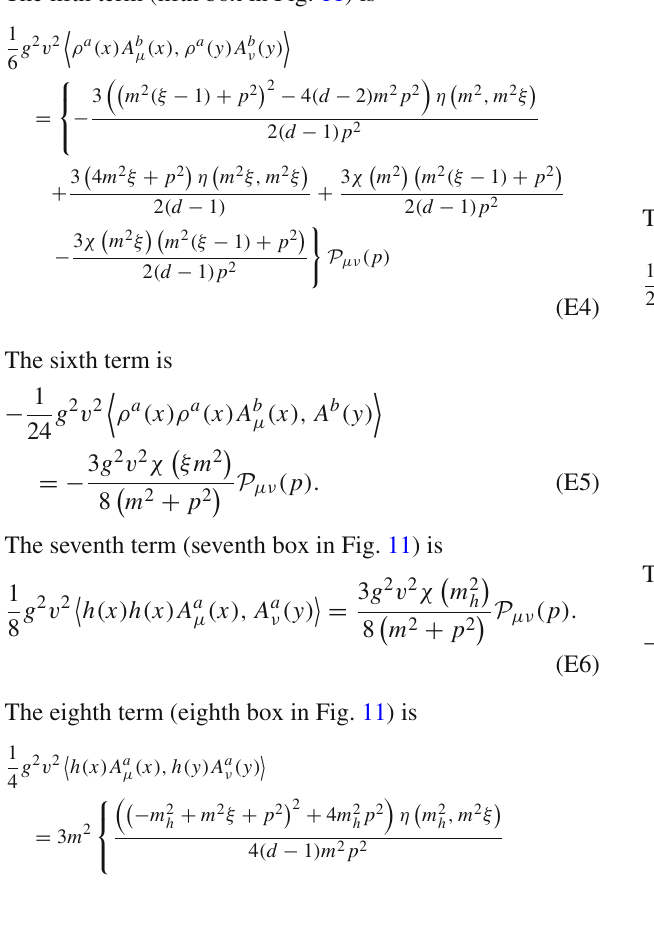
The fifth term (fifth box in Fig. 11)